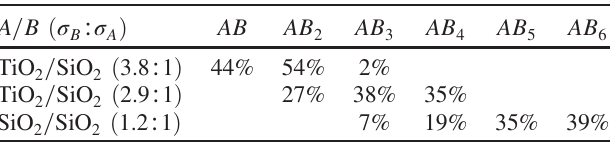
TABLE II. Yields of the titania-silica or silica-silica clusters for different size ratios. The cluster type is given as the type of core ( A )/satellite ( B ) particles and their respective size ratios, σ B ∶ σ A . The percentages were estimated by analyzing 100-150 clusters, ignoring excess satellite particles that were not part of a cluster.